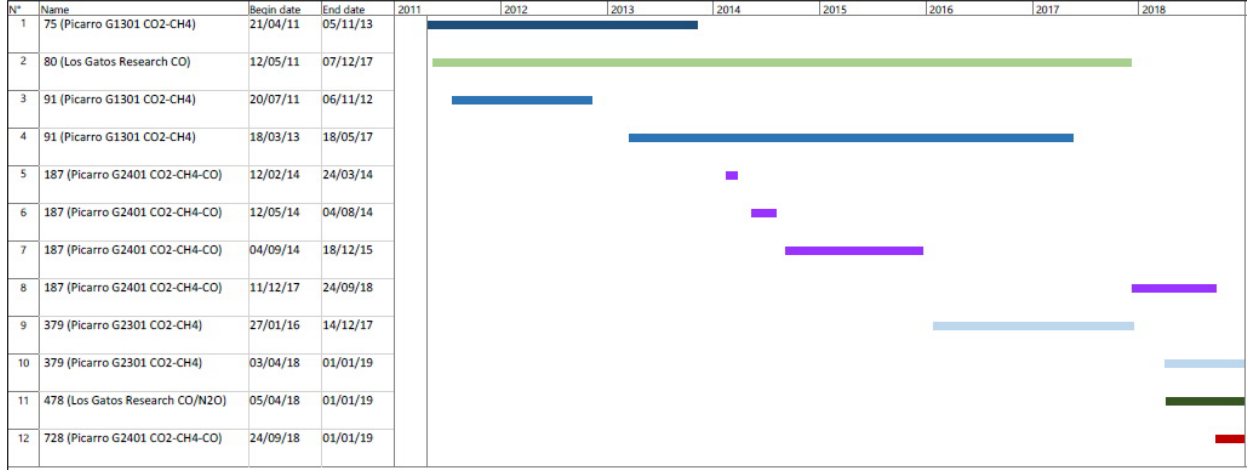
lators from 50 L Luxfer aluminium cylinders. Before